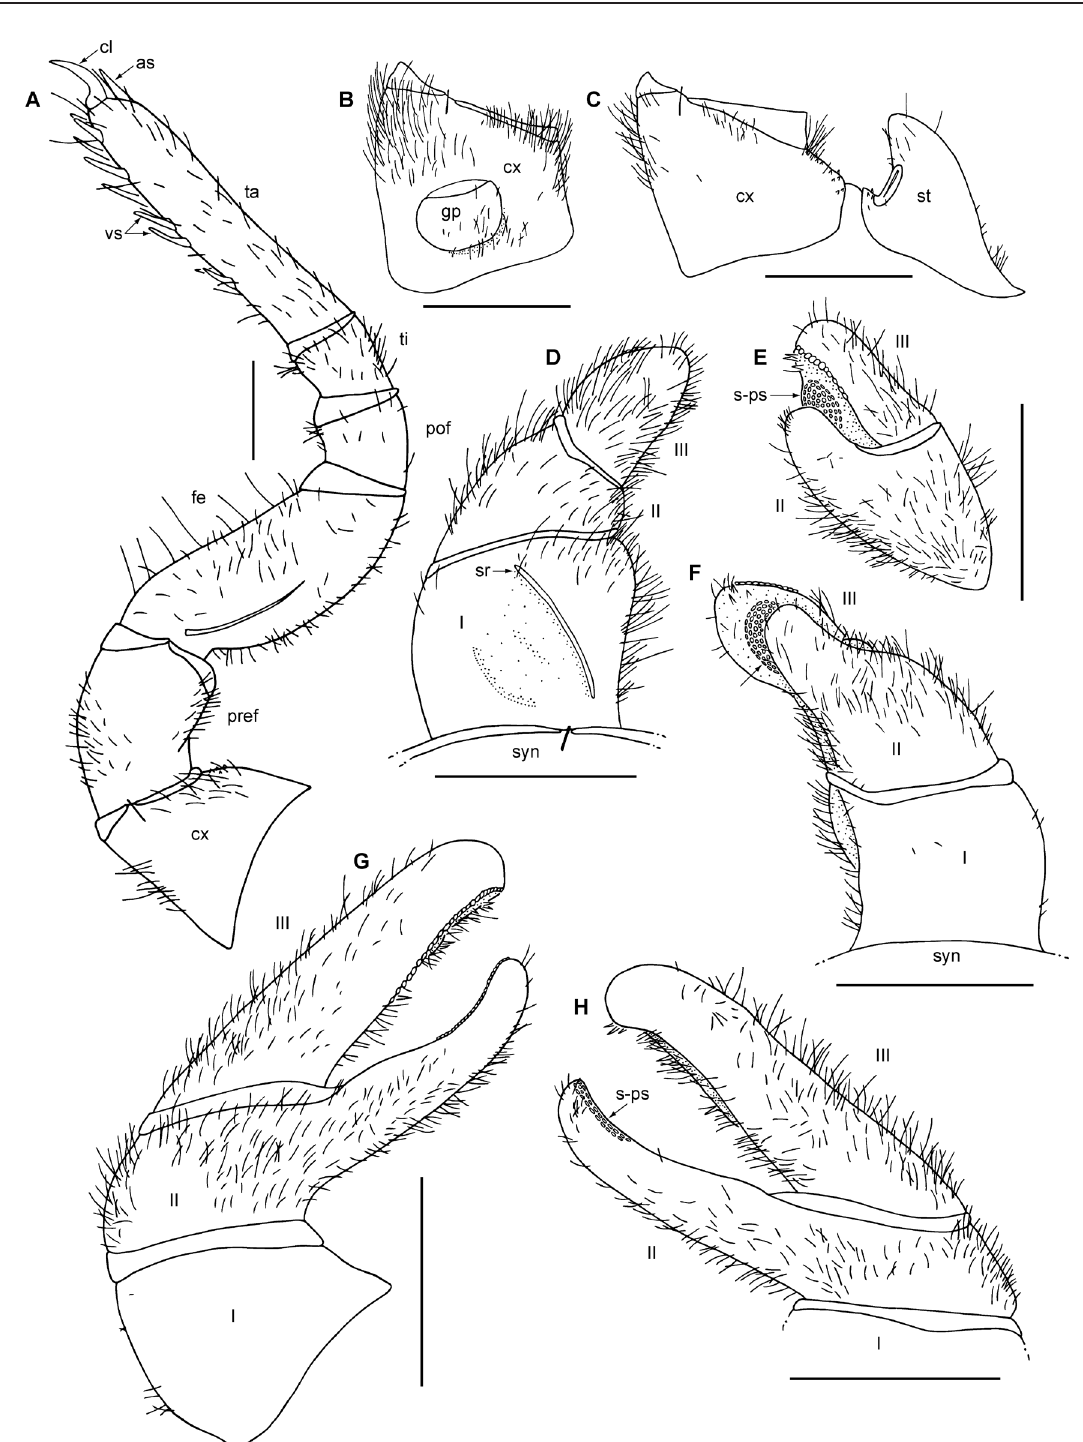
Fig. 9. Zoosphaerium voahangy sp. nov., holotype (FMNH-INS 3119921). A . left leg 9, posterior view. B . Left coxa 2 with gonopore, posterior view. C . Left coxa 1 with stigmatic plate, posterior view. D . Left anterior gonopod, anterior view. E . Left anterior gonopod, lateral view. F . Left anterior gonopod, posterior view. G . Right posterior telopod, posterior view. H . Right posterior telopod, anterior view. Abbreviations: as = apical spine; cl = claw; cx= coxa; fe = femur; gp = gonopore; pof = postfemur; pref = prefemur; s-ps = sclerotized spots; sr = stridulation rib; st = stigmatic plate; syn = syncoxite; ta = tarsus; ti = tibia; vs = ventral spines. Roman numerals indicate telopoditomeres. Scale bars = 1